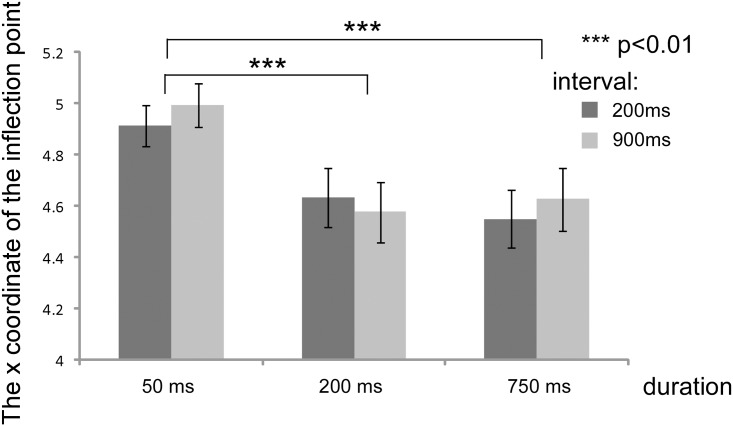
Changes in the category boundary in the identification task.The y-axis represents the mean of the morphing intensity of the category boundary. The differences between durations of 50 and 200 ms and between 50 and 750 ms are significant. Error bars indicate the standard error.